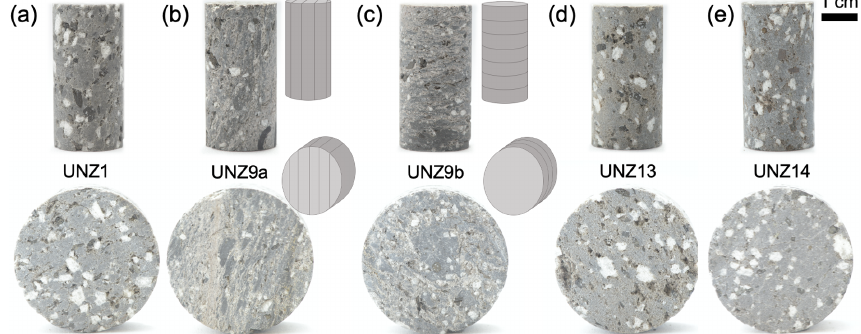
Figure 2. Photographs of sample cores used for uniaxial compressive strength (UCS) tests and discs used for indirect tensile strength testing (UTS) using the Brazilian disc method: (a) UNZ1 – an isotropic dacite of medium porosity with large euhedral phenocrysts and pore space comprising vesicles adjacent to phenocrysts as well as microfractures traversing the groundmass; (b) UNZ9a – a cataclastic dacite with clear subparallel cataclastic banding comprised of fractured phenocrysts and porous fault gouge cored parallel to the fabric (see inset schematic), both void spaces and crystals (often fragments) are smaller than in isotropic sample UNZ1; (c) UNZ9b – the same cataclastic sample cored perpendicular to the fabric (see inset schematic); (d) UNZ13 – the lowest density sample with large phenocrysts, large sub-rounded vesicles, and varying degrees of coalescence often positioned in close proximity to crystals; (e) UNZ14 – the densest sample selected for the study also has large euhedral phenocrysts, with typically smaller pores and fine fractures traversing the dense groundmass. For all samples, the direction of the principal applied stress during mechanical testing is